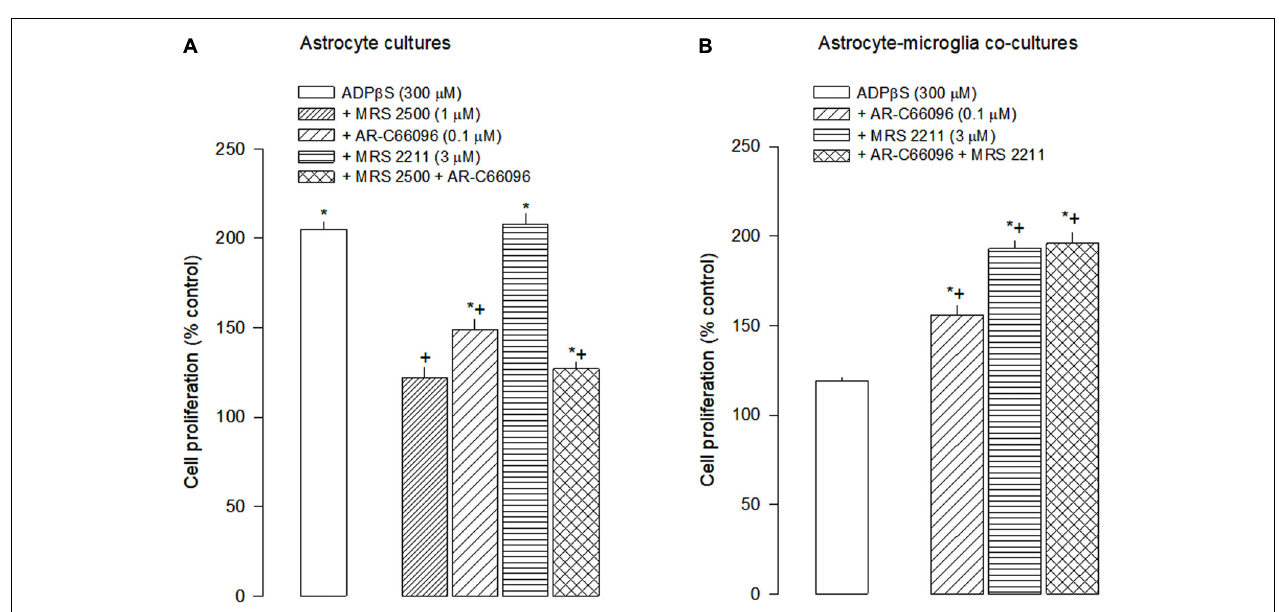
FIGURE 3 | Pharmacological characterization of P2Y receptors involved in the modulation of ADP β S-mediated astroglial proliferation. (A) Astrocyte cultures and (B) astrocyte-microglia co-cultures were incubated with ADP β S or solvent for 48 h and methyl -[ 3 H]-thymidine (1 µ Ci/mL) was added in the last 24 h. The P2Y antagonists: MRS 2500 (anti-P2Y 1 R), AR-C66096 (anti-P2Y 12 R) and MRS 2211 (anti-P2Y 13 R) were added to the medium 1 h before ADP β S. Cell proliferation was estimated by methyl -[ 3 H]-thymidine incorporation and expressed in percentage of control. Values are means ± SEM from 6 to 10 different cultures. ∗ P < 0.05, significant differences from control (solvent). + P < 0.05, significant differences from ADP β S